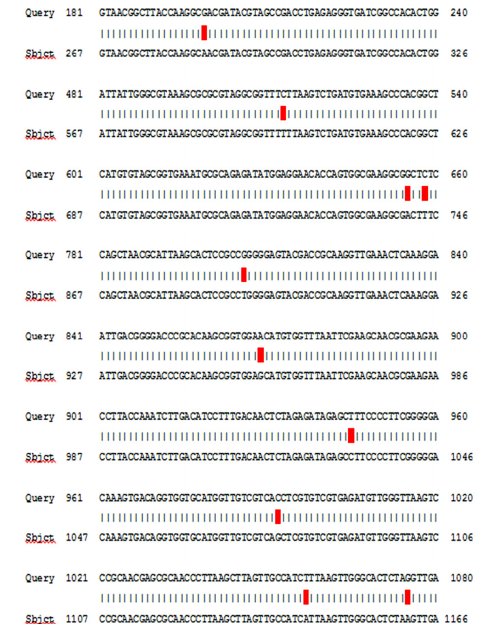
Fig. 2. Sequencing of Staphylococcus aureus obtained from Gene Bank.